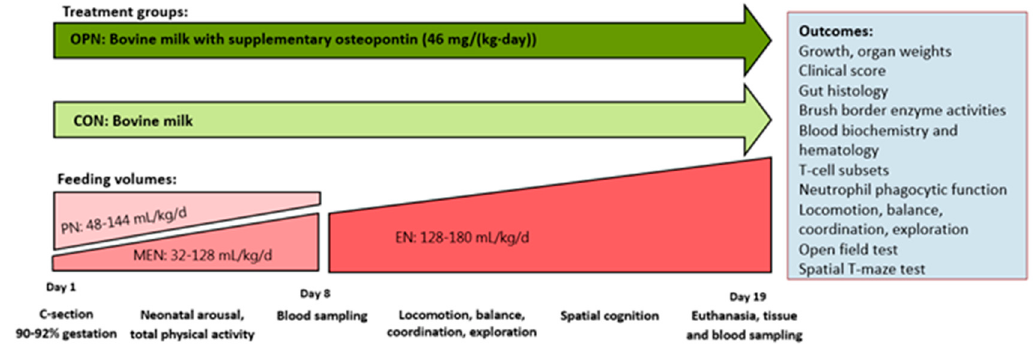
Figure 1. Outline of study design, treatment groups and interventions. OPN, osteopontin; CON, control.